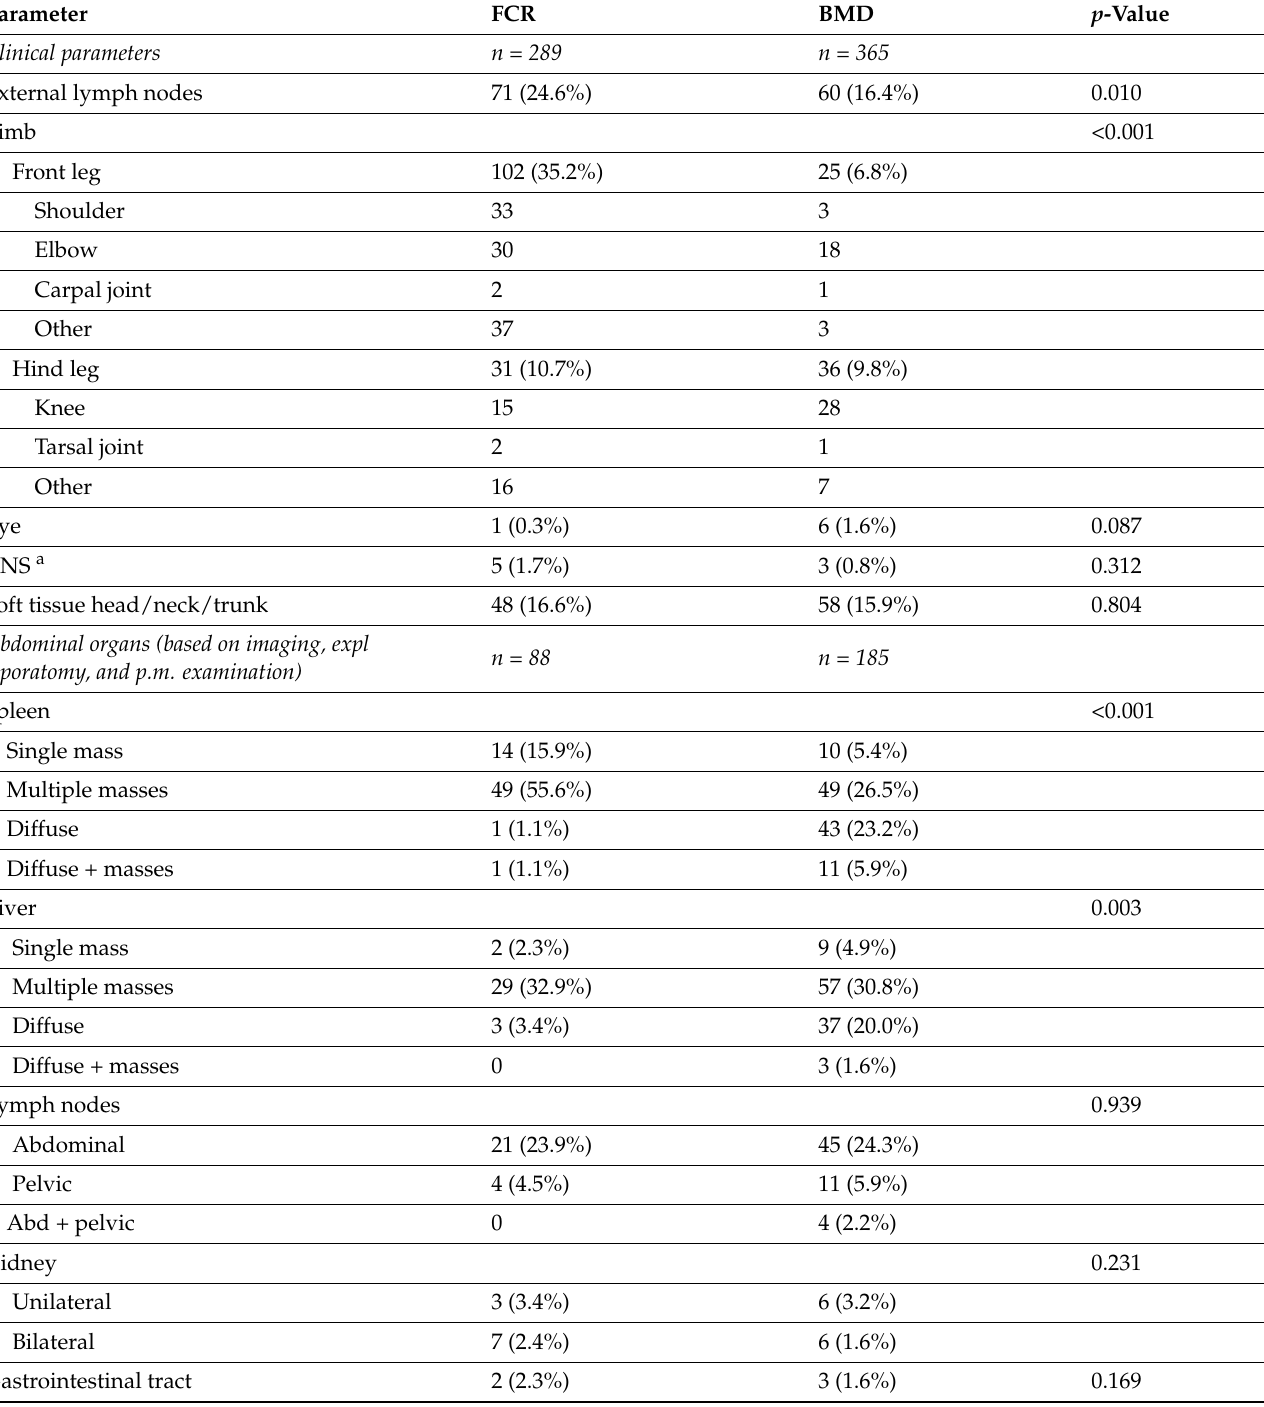
Table 4. Comparison of tumor location of HS in FCR and